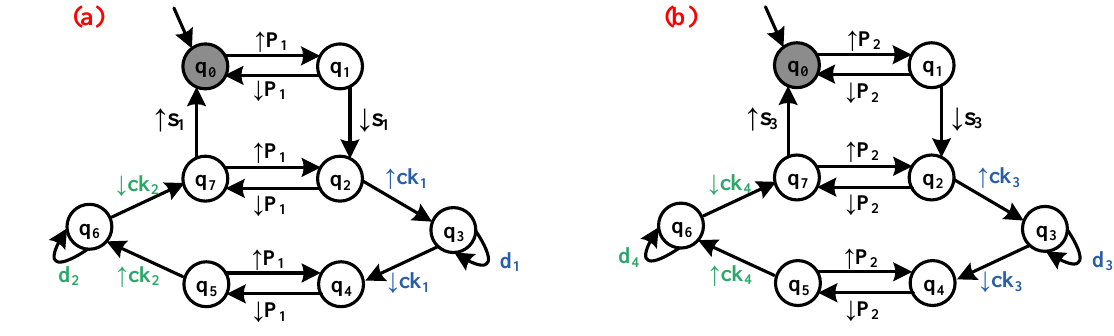
Figure 9. Degraded behavior models of: ( a ) P1, ( b )